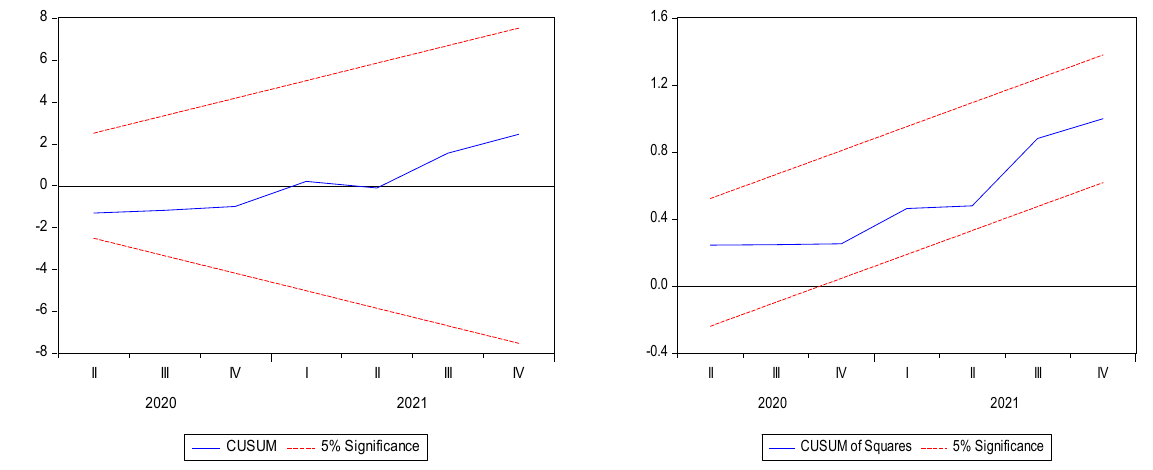
Fig. 5 . CUSUM and CUSUM square test of EN  Tr in NARDL